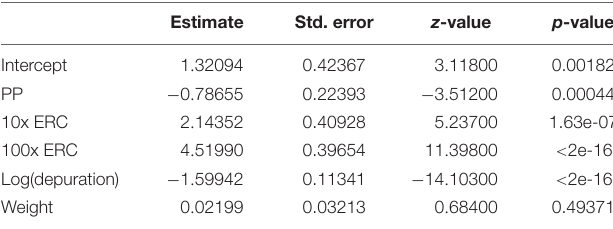
TABLE 5 | Differences in body burden over time due to microplastic type, microplastic concentration or fish weight, following a single exposure of